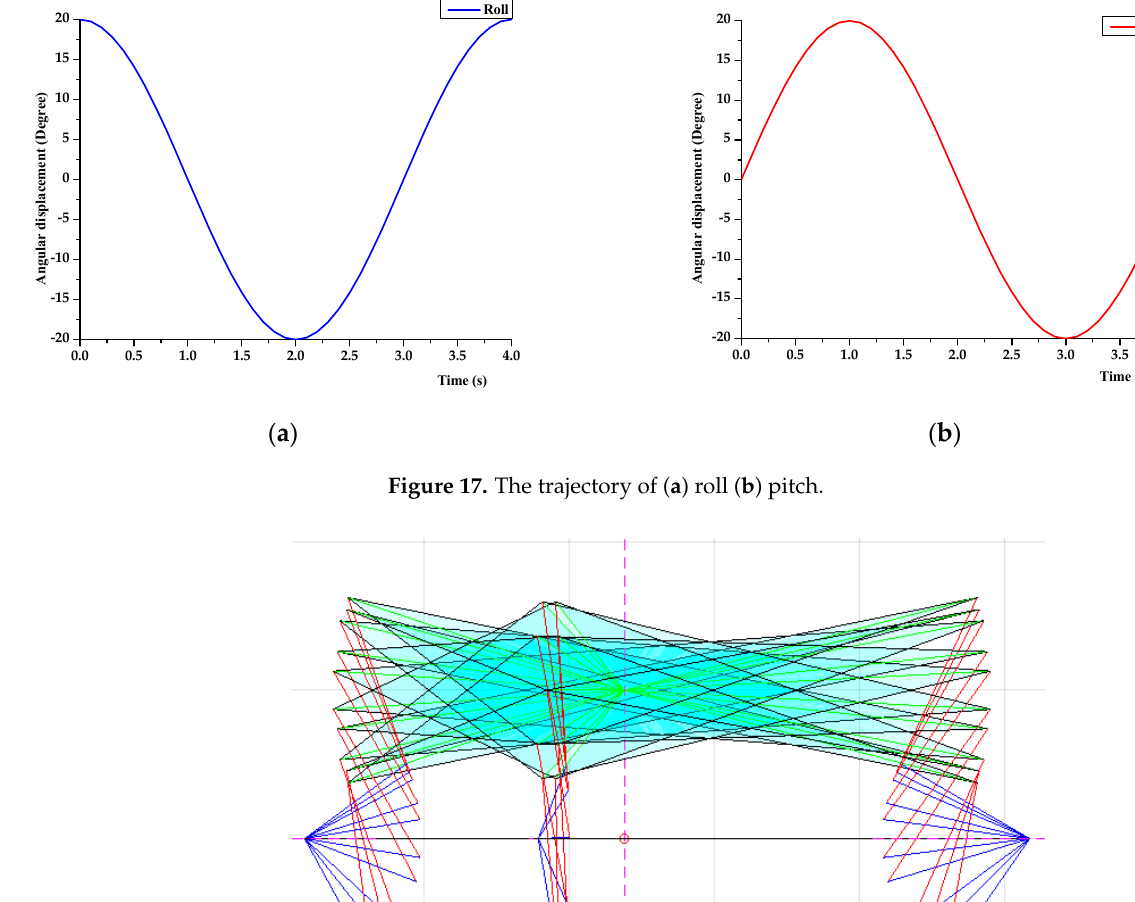
Figure 17. The trajectory of ( a ) roll ( b ) pitch.